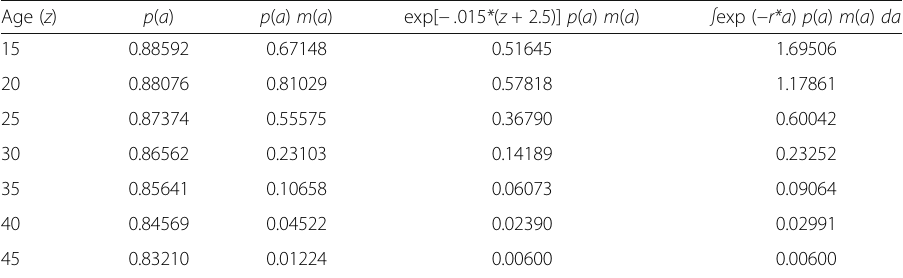
R μ =24.37, r =0.036 0 =2.43, 1 Here, z is the lower limit of the age class, e.g., in class (15 – 20), 15 is the lower limit and a is the mid value of age